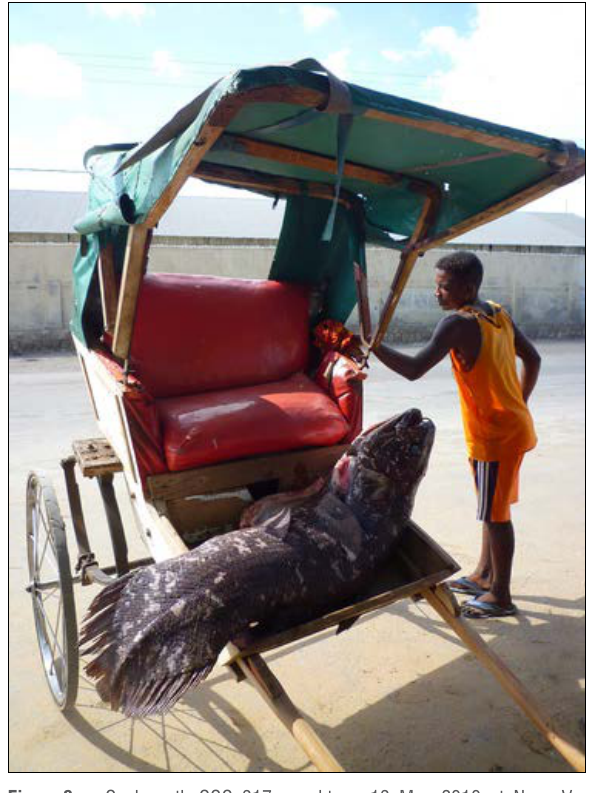
Figure 3: Coelacanth CCC 317 caught on 13 May 2010 at Nosy Ve, identified by IHSM Museum staff, and sold in the market at Toliara (photo: T.